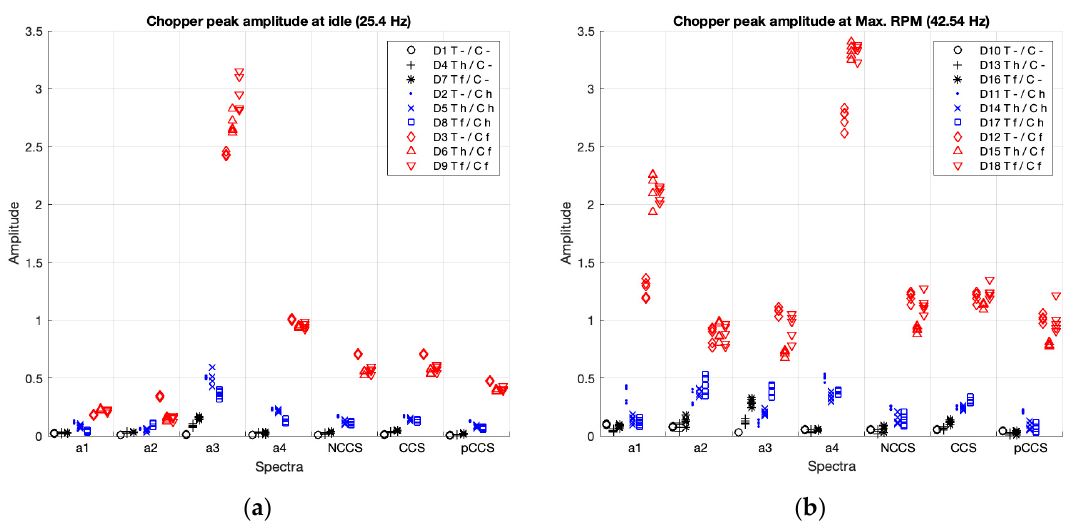
Figure 8. Peak amplitudes of the chopper in the individual spectra (a1–4) and the non-coherent (nCCS), coherent (CCS), and poly-coherent (pCCS) composite spectra at idle ( a ) and at maximum RPM ( b ). The balanced cases are shown in blue, the unbalanced cases in red, and deactivated components, in black.